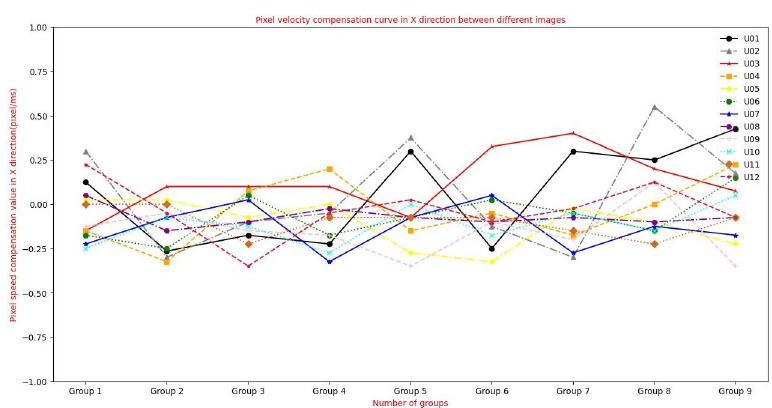
Fig 14. Variation curve of pixel speed compensation in X direction calculated by extended L-K optical flow.